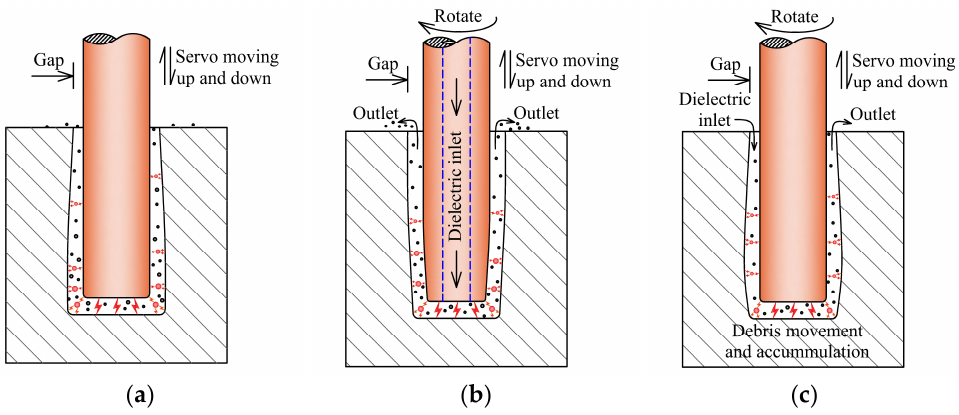
Figure 1. Gap clearance distortion: ( a ) Reverse taper, ( b ) V-shaped taper, ( c ) barrel taper. Flushing plays a crucial role in the EDM process, since flushing removes debris from the machining gap and affects the EDM performance and deep hole characteristics [13].